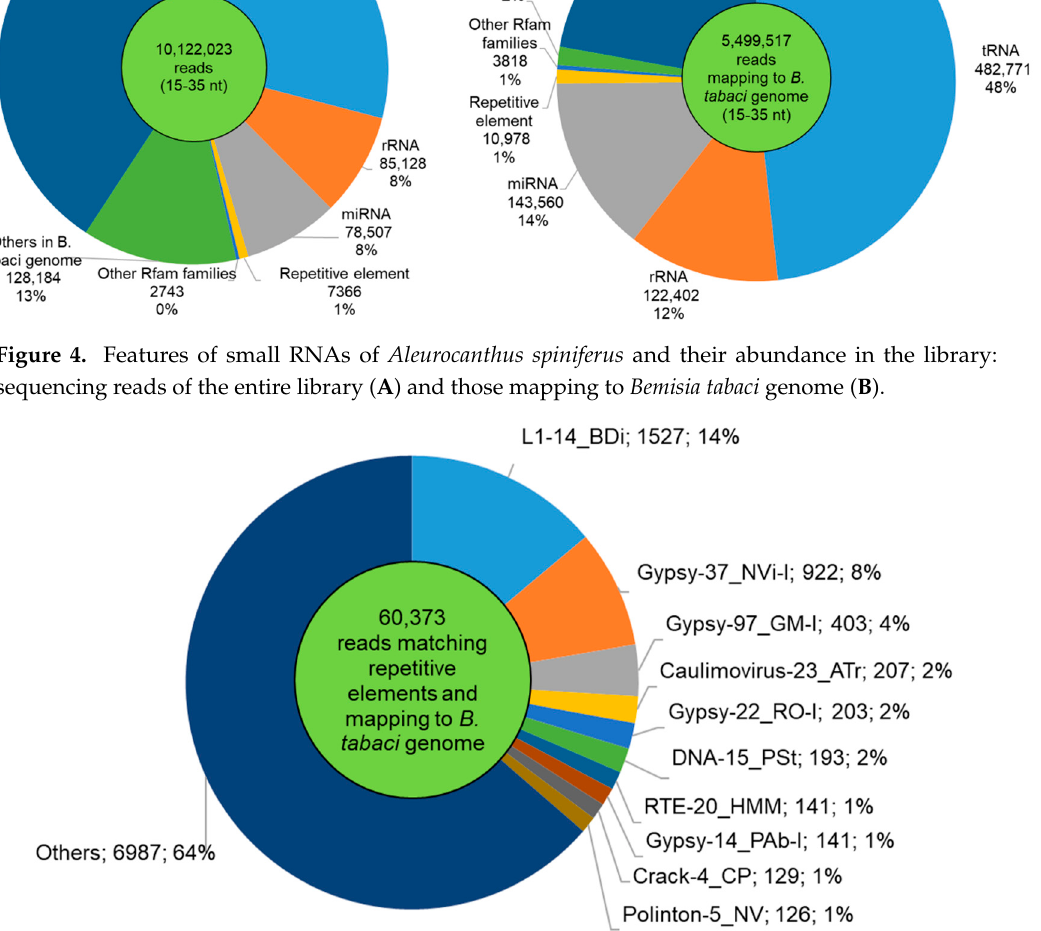
Figure 5. Abundance of several transposable element families in the Aleurocanthus spiniferus library.